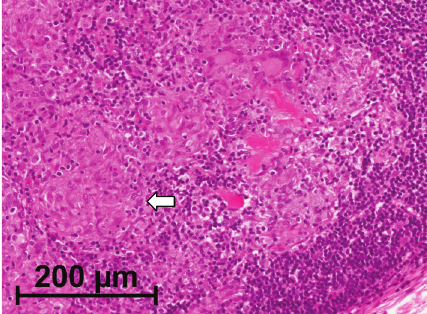
Figure 1: Ultrasound image for Case 1, showing the enlarged right parotid gland and interspersed hypoechoic areas (arrow).